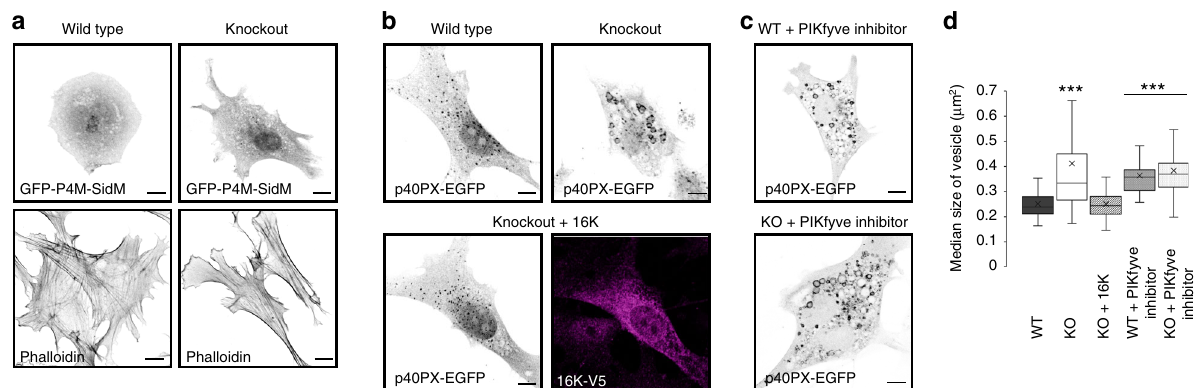
Fig. 7 Endolysosomal phosphatidylinositols. a Confocal images of WT and TMEM16K KO cells transfected with GFP-P4M-SidM, biosensor for PtdIns4P or labeled with fl uorescence conjugated phalloidin which speci fi cally labels actin network. Representative images from two independent experiments. Scale bar 10 µ m. b . Confocal images of WT, TMEM16K KO cells and KO cells with reintroduced TMEM16K cells transfected with PtdIns3P biosensor P40PX- EGFP. Scale bar 10 μ m. c . Confocal images of WT and TMEM16K KO cells transfected with PtdIns3P biosensor P40PX-EGFP and treated with PIKfyve kinase inhibitor YM201636. Scale bar 10 μ m. d . Quanti fi cation of the median size of the PtdIns3P positive vesicles per cell visualized with P40PX-EGFP from 3 biological replicates in the WT, TMEM16K KO and TMEM16K KO cells transfected with wild type TMEM16K cDNA, as well as WT and TMEM16K KO cell treated with YM201636. Single factor ANOVA, p value = 6.82E − 63 with post-test Bonferroni-corrected two sided t -test with pairwise comparison with WT. ( n = 131 WT, n = 131 KO, p value = 1.50E − 18***, n = 153 KO + 16K, n = 150 WT + PIKfyve inhibitor, p value = 5.86E − 42***, n = 156 KO + PIKfyve inhibitor, p value = 1.59E − 41***). In the box and whiskers plot, the box includes the fi rst quartile and the third quartile, with the central line representing the median. Whiskers represent the minimum and maximum values of data. X inside the box represents the mean of data. Source data are provided as a Source Data fi